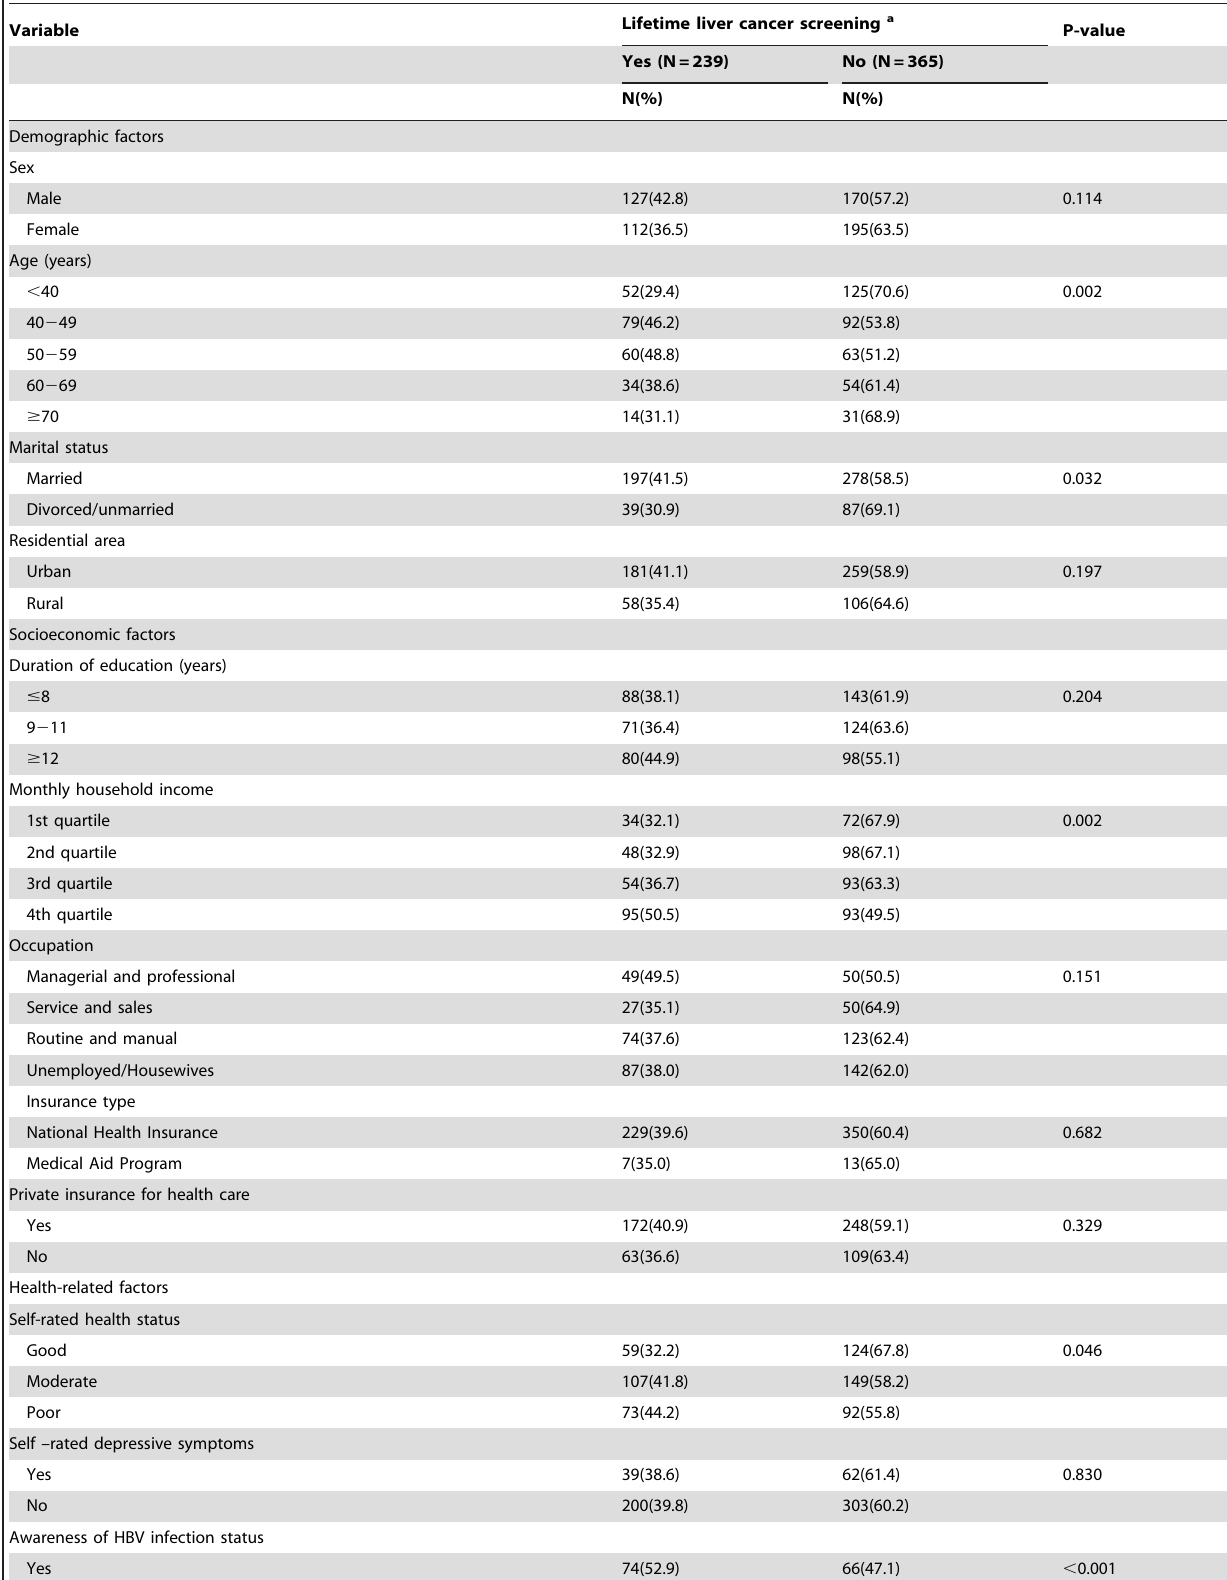
Table 1. Basic characteristics of the study